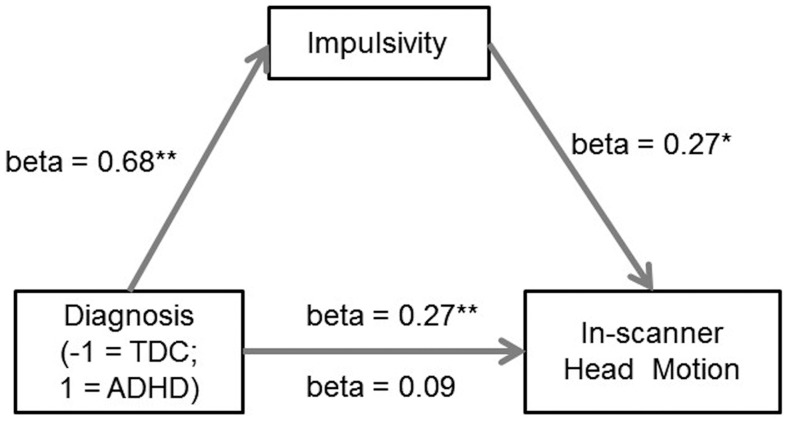
Impulsivity as a sufficient mediator of the difference in head motion between ADHD and TDC in the mediation analysis.Path coefficients are shown next to arrows indicating each link in the analysis. For the group difference in head motion, the value above the arrow indicates the zero-order correlation, and the value below the arrow represents the correlation after controlling the mediator of impulsivity. All values represent standardized betas. * indicates p < 0.01, ** indicates p < 0.001, two-tailed. ADHD: attention deficit hyperactivity disorder; TDC: typically developing children.